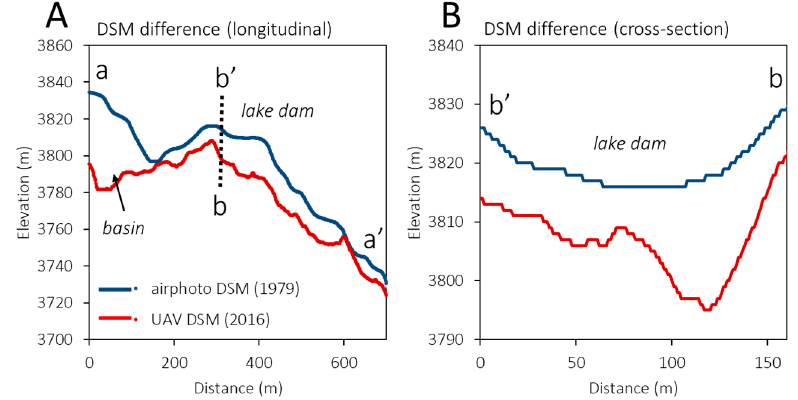
Figure 4. Surface changes of the debris landform at Jeruy Glacier between 1979 and 2016. Data based on orthoimages from air photos (1979) and digital images taken by a UAV (2016).